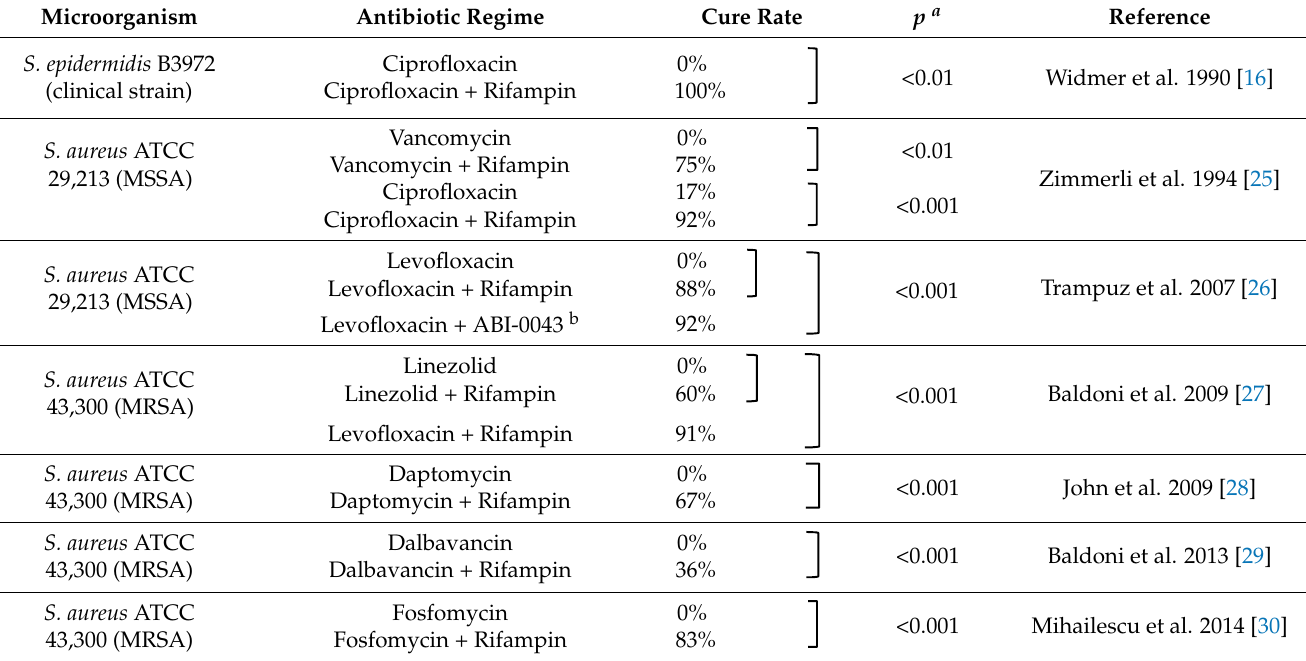
a Fisher’s exact test for categorical variables, statistical significance is defined as p < 0.05. b ABI-0043 is a derivative of Rifalazil, which is a rifamycin derivative.